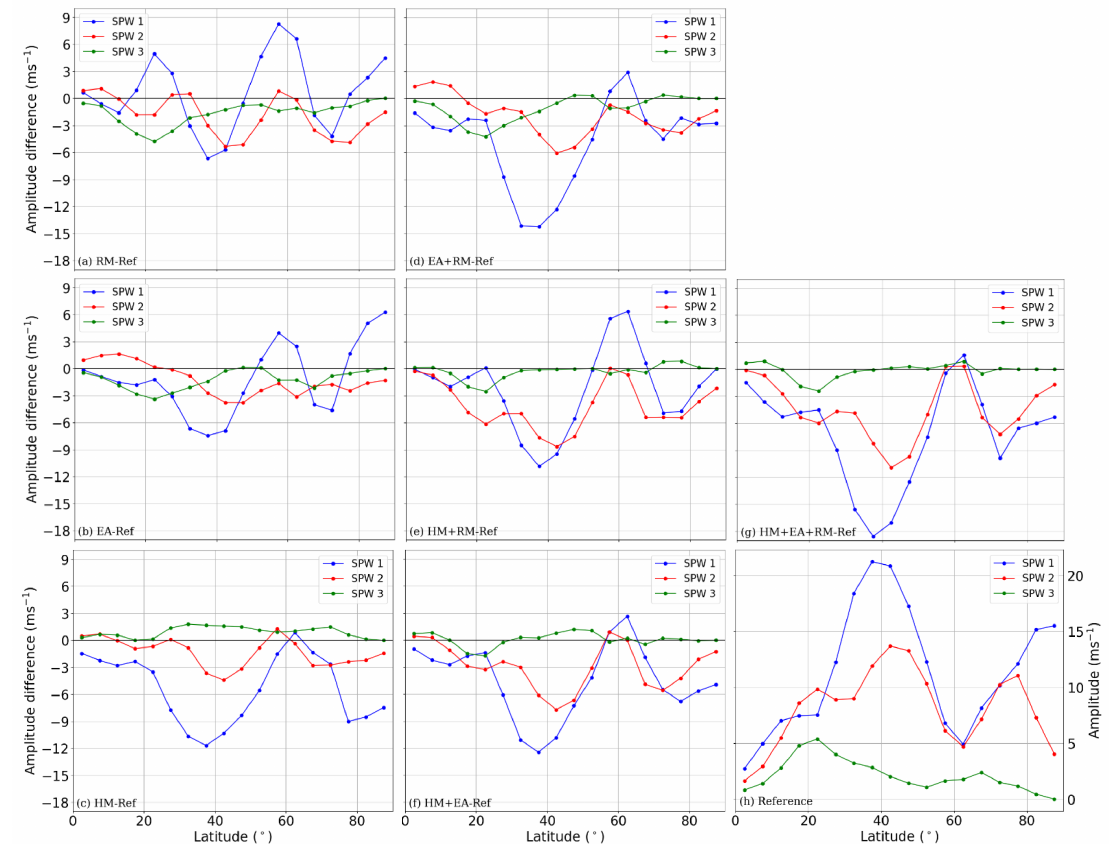
Figure 5. Latitude-wavenumber analysis of the zonal wind SPW from the reference simulation at 38km (lower right panel), and the amplitude differences between each experiment and the reference simulation ( h ). The left column represents the differences for the RM ( a ), EA ( b ) and HI ( c ) simulations. The middle column represents those of the RM + EA ( d ), RM + HI ( e ) and HI + EA ( f ) simulations. The right column shows the differences for the RM + HI + EA ( g )